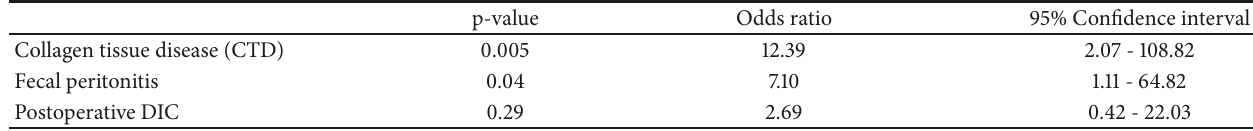
Table 2: Prognostic factors for mortality within 28 days after surgery in all